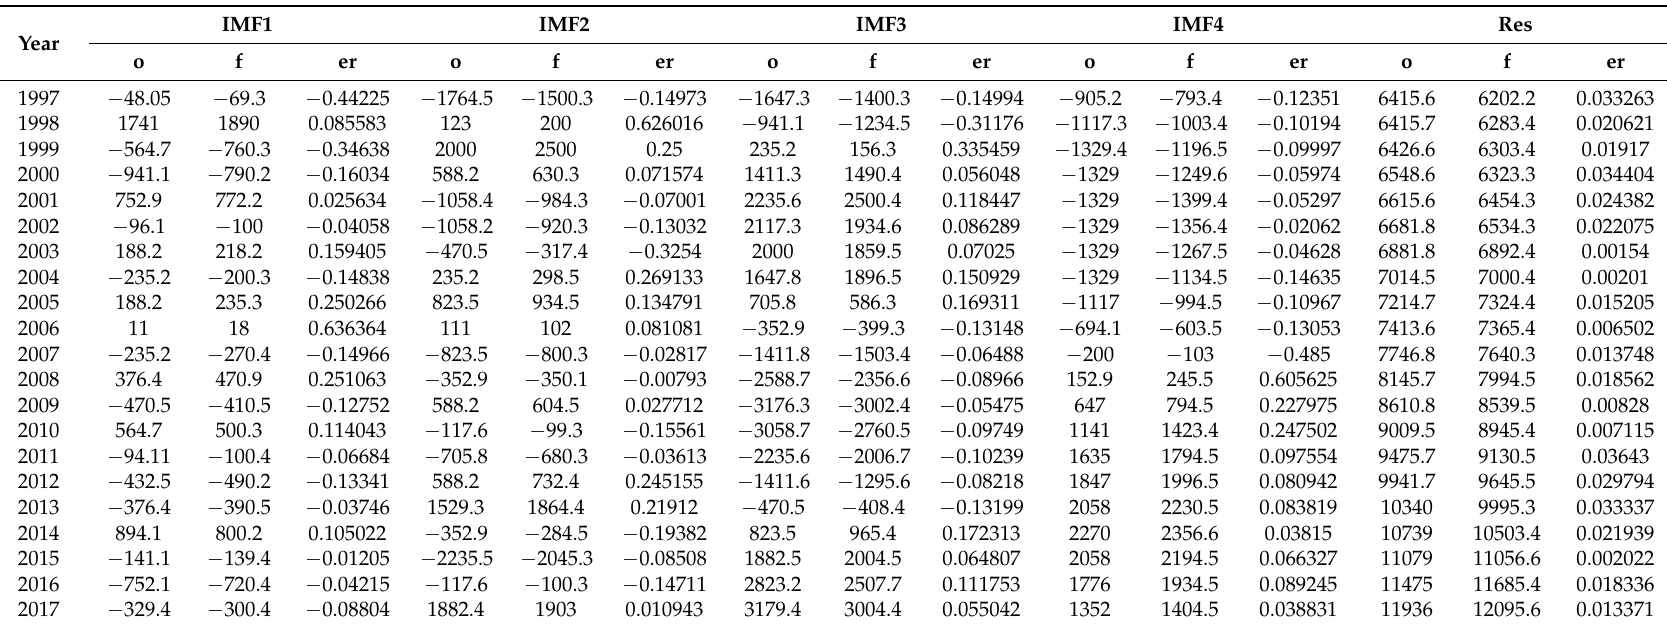
Table A1. The predicted results of the test sets by the proposed